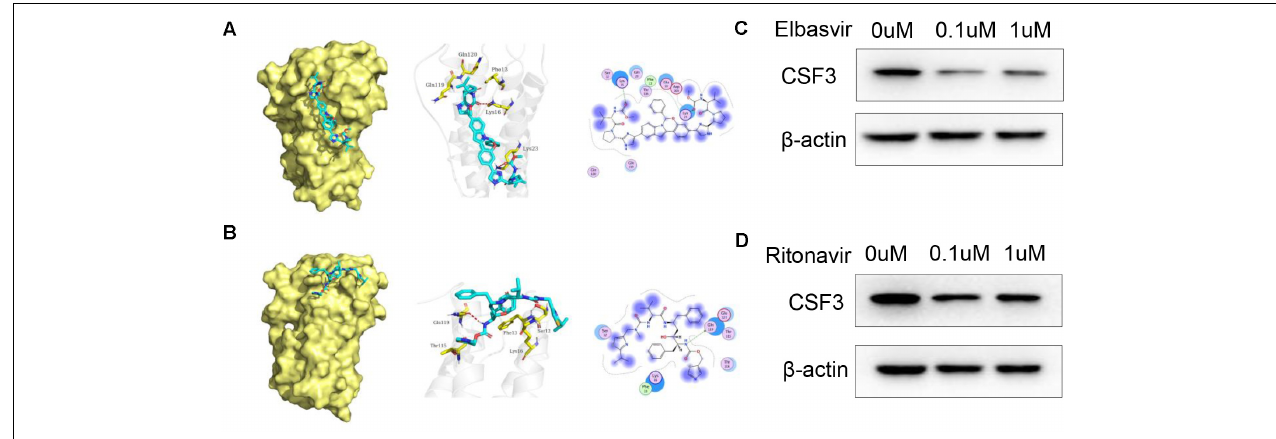
FIGURE 4 | Docked pose of CSF3 with Elbasvir and Ritonavir. (A) Overall structural view of CSF3 with Elbasvir, wherein Elbasvir are chimeric into protein; Detailed interaction view between Elbasvir and CSF3 wherein hydrogen bonding is shown as a red dashed line; 2D interaction view between Elbasvir and CSF3, with green arrows representing hydrogen bonding interactions. (B) Overall structural view of CSF3 with Ritonavir, wherein Ritonavir are chimeric into protein; Detailed interaction view between Ritonavir and CSF3 wherein hydrogen bonding is shown as red dashed line; 2D interaction view between Ritonavir and CSF3, with green arrows representing hydrogen bonding interactions. (C,D) Both Elbasvir and Ritonavir inhibited CSF3 expression in A549 cells when treated with 0.1 and 1 µ M of Elbasvir/Ritonavir for 24 h.